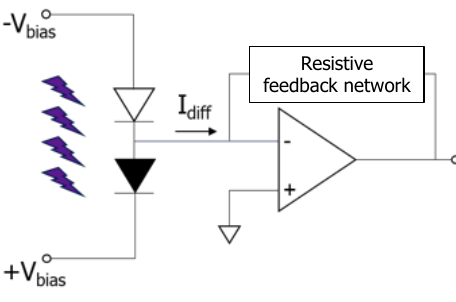
Figure 2. Schematic of the electrical connections of the differential structure. The two diodes work at reverse bias. A current to voltage converter circuit reads the differential current.